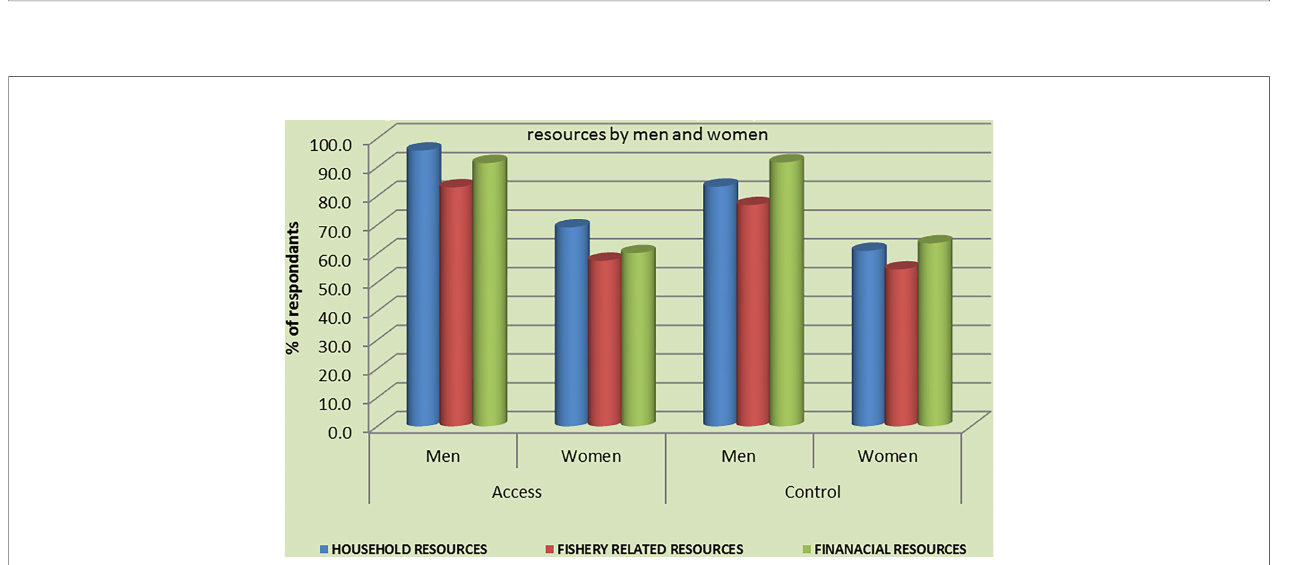
FIGURE 7 | Access and control over household, fi sheries, and fi nancial resources by men and women.